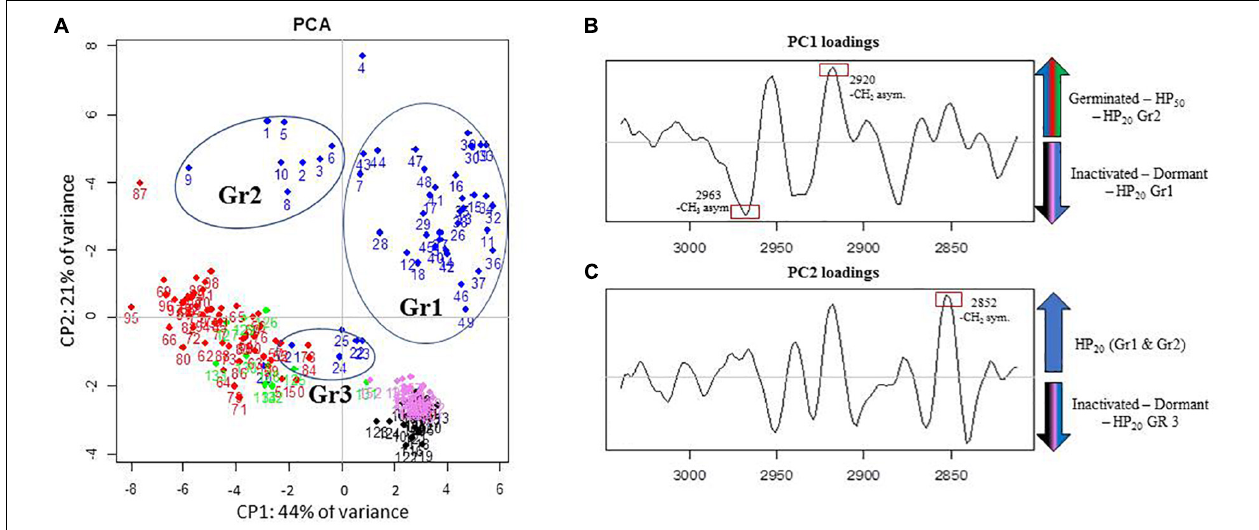
FIGURE 4 | Principal component analysis (PCA) of infrared spectra obtained on control spore samples (germinated: green dots; dead: black dots; dormant: pink dots) and spores treated by high pressure (HP) at 500 MPa for 10 min at 50 ◦ C (red dots) or 20 ◦ C (blue dots) in the spectral region of lipids (3,050–2,800 cm − 1 ). (A) Principal component 1 (PC1) vs. principal component 2 (PC2) score plots in the spectral regions of lipids (3,050–2,800 cm − 1 ); (B) PC1 loadings plot; (C) PC2 loadings